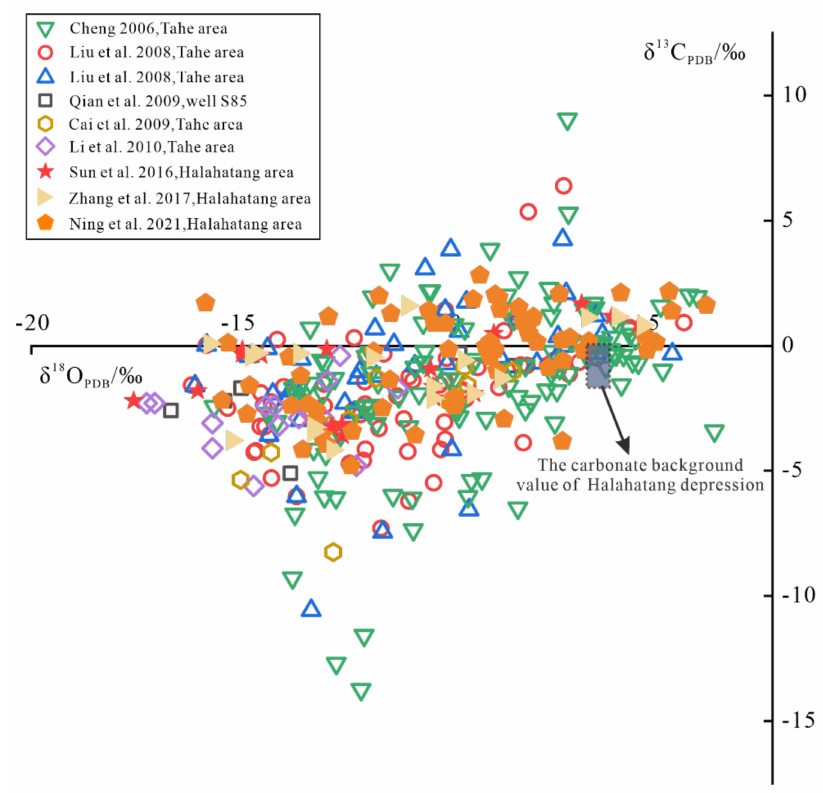
Figure 4. Distribution of δ 13 C and δ 18 O of calcite in the Tahe and Halahatang areas. The genesis of calcite in the Halahatang depression was mainly influenced by paleo-meteoric water referred to in the previous studies